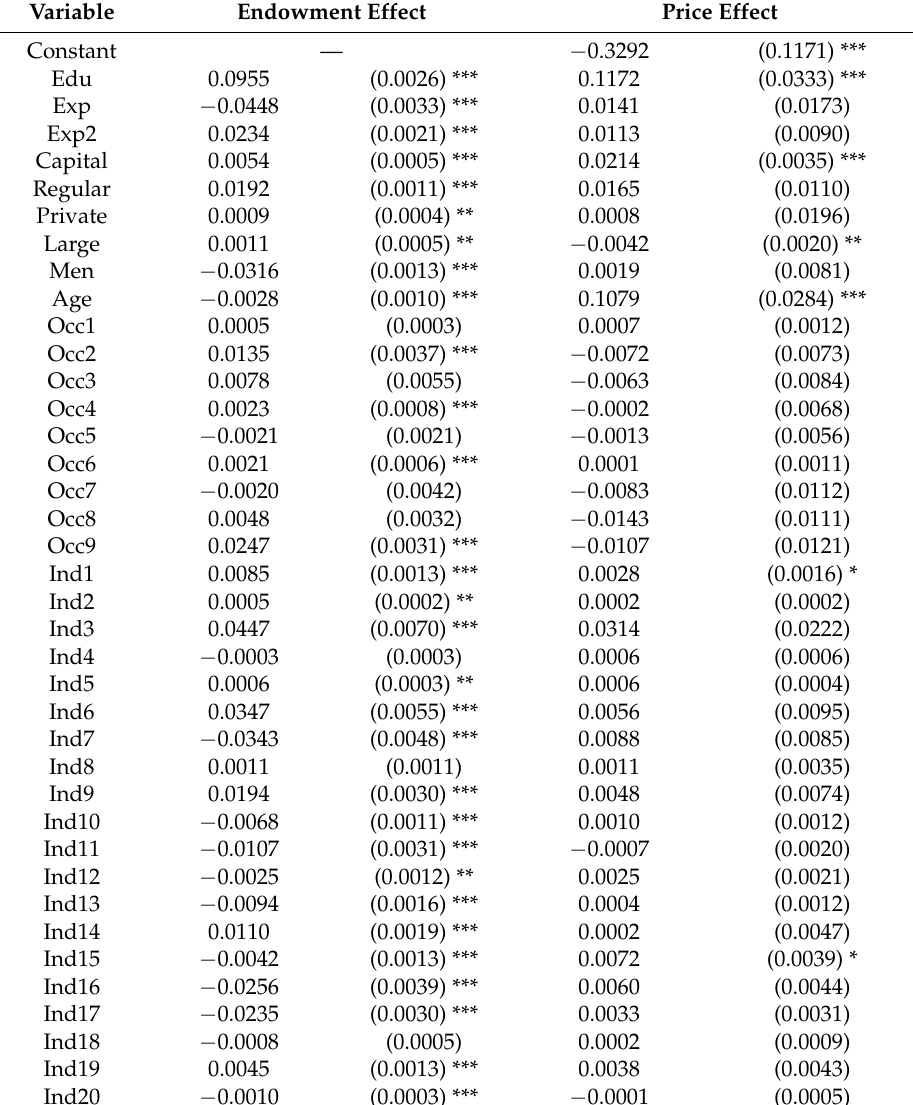
Table 5. Details of the Blinder-Oaxaca